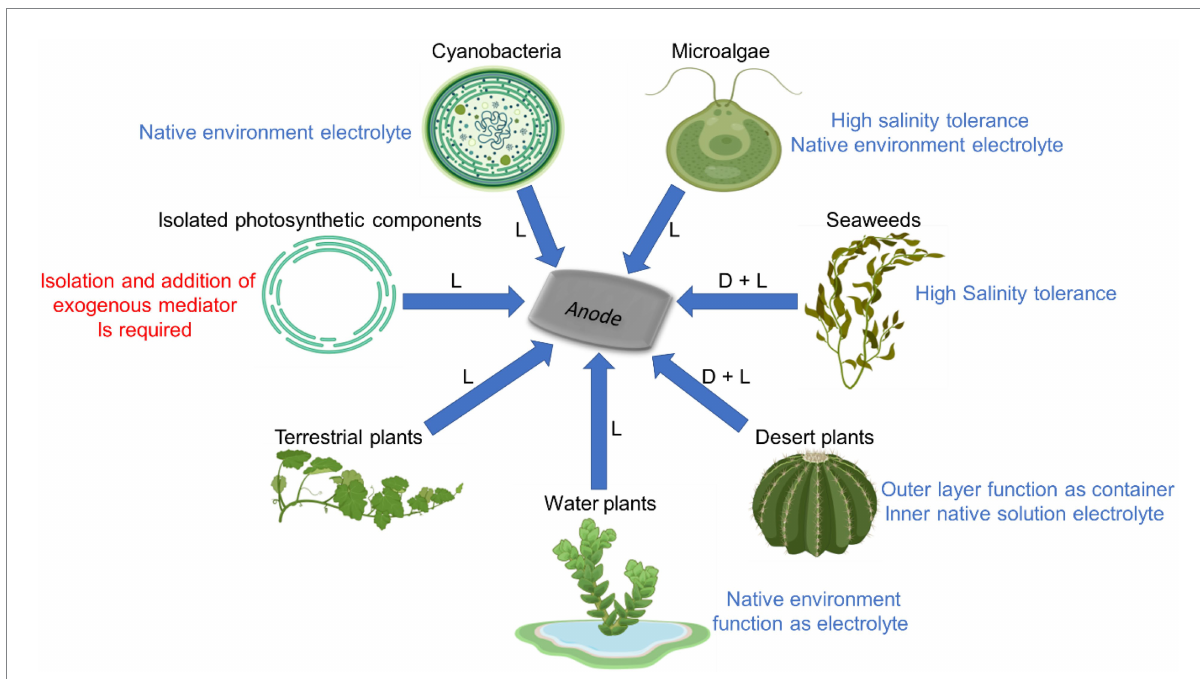
FIGURE 5 Advantages and disadvantages of using different photosynthetic organisms in BPECs. Among the different photosynthetic organisms that can produce electricity in BPECs are cyanobacteria, microalgae, seaweeds, terrestrial plants, desert plants and water plants. Electricity can be also produced from thylakoids membranes, isolated chloroplasts or purified photosystems isolated from various photosynthetic organisms. Different organisms have unique advantages for being used in BPECs. For aquatic organisms such as cyanobacteria, microalgae, seaweeds and water plants it is possible to use their environmental growth media as an electrolyte. Cyanobacteria, microalgae and all seaweed which habitatthat grow in aquatic marine environment can tolerate a high electrolyte salinity that enhance the photocurrent and therefore these are benefited for the BPEC. Desert plants have a thick cuticle that can be applied as the container and the electrochemical cell, while its inner solution can apply as the electrolyte of the electrochemical cell. Seaweeds and desert plants produce also a significant dark electricity which is enhanced in the light. Some photosynthetic organisms produce significant current using their endogenous electron mediators while an exogenous mediator must be added to thylakoids and several green algae BPECs in order to obtain significant currents. Blue arrows indicate electron flow from the organisms to the anode of the BPEC. (D, L) indicate the ability to produce a substantial electrical current in dark and light, respectively. The figure was created using